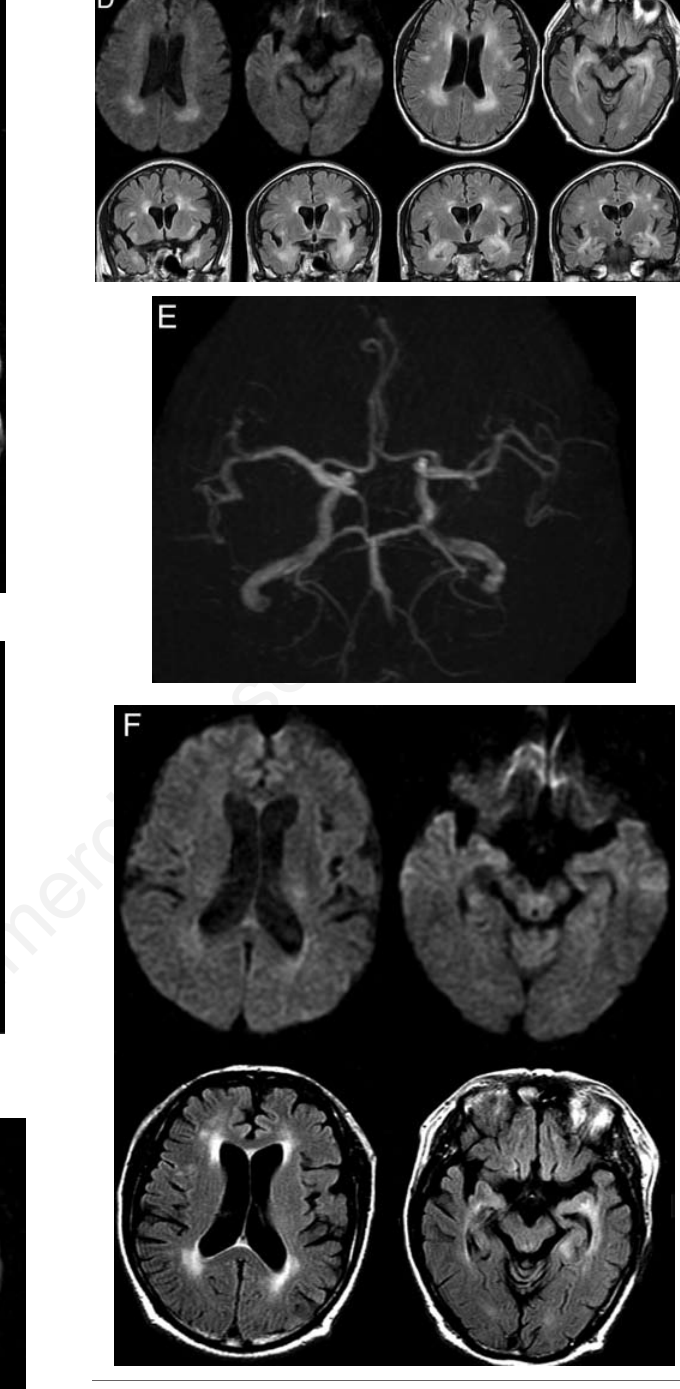
Figure 1. (A) Magnetic resonance imaging on Day 2 showed hyperin- tensity in the bilateral medial temporal cortex on diffusion-weighted imaging and fluid attenuated inversion recovery. (B) Magnetic reso- nance angiography showed no abnormalities. (C) Diffusion-weighted imaging and fluid attenuated inversion recovery on Day 14 revealed other hyperintense lesions around the lateral ventricles. (D) Diffusion-weighted imaging and FLAIR on Day 37 revealed that hyperintense lesions in the bilateral medial temporal cortex became more apparent in fluid attenuated inversion recovery image and lesions around the lateral ventricles remained. (E) Magnetic resonance angiography did not show any abnormal findings. (F) Magnetic reso- nance imaging 17 months later showed hyperintense lesions in the bilateral medial temporal cortex and on fluid attenuated inversion recovery the lesions around the lateral ventricles